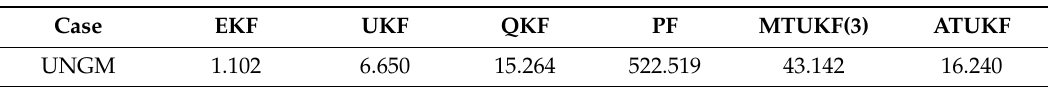
Table 1. Comparison of the computation times of different filtering algorithms (s). UNGM: univariate nonstationary growth model.